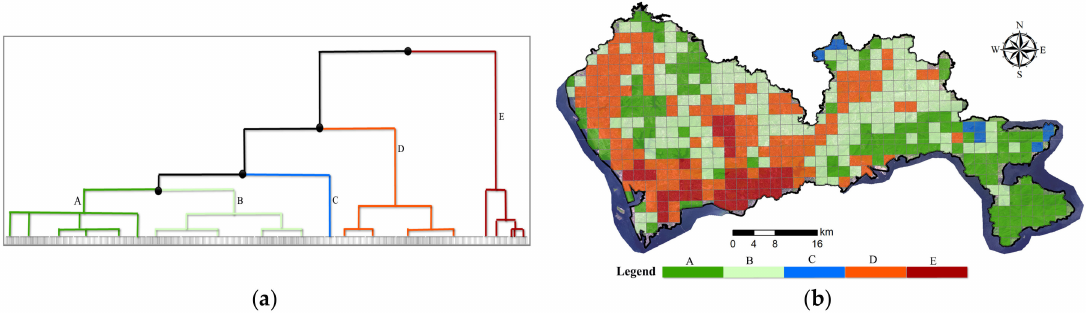
Figure 14. Cluster result with human activity: ( a ) the dendrogram; ( b ) clustering